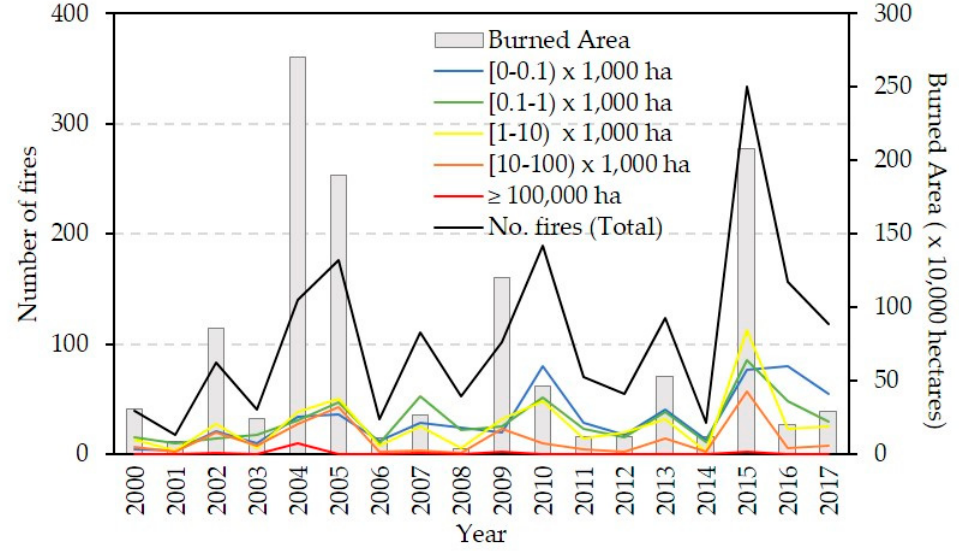
Figure 2. Temporal distribution of the annual burned area in Alaska during the period 2000–2017 and distribution per year of the number of fires by size (in thousands of hectares), according the Alaska Fire Service (AFS, Fort Wainwright, AK, USA). Five categories were considered for the sizes (BA extension in ha) of the fires: very small (<100 ha), small ( ≥ 100 ha and <1000 ha), medium ( ≥ 1000 ha and <10,000 ha), large ( ≥ 10,000 ha and <100,000 ha) and very large ( ≥ 100,000 ha).